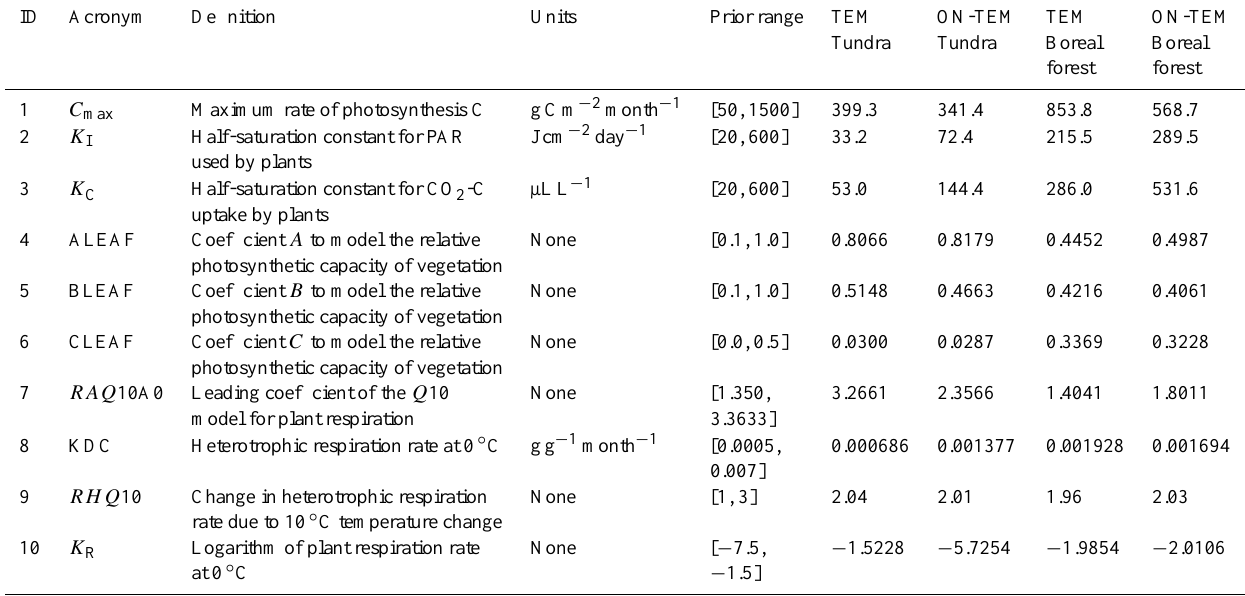
Table 2. Optimized parameters in TEM and